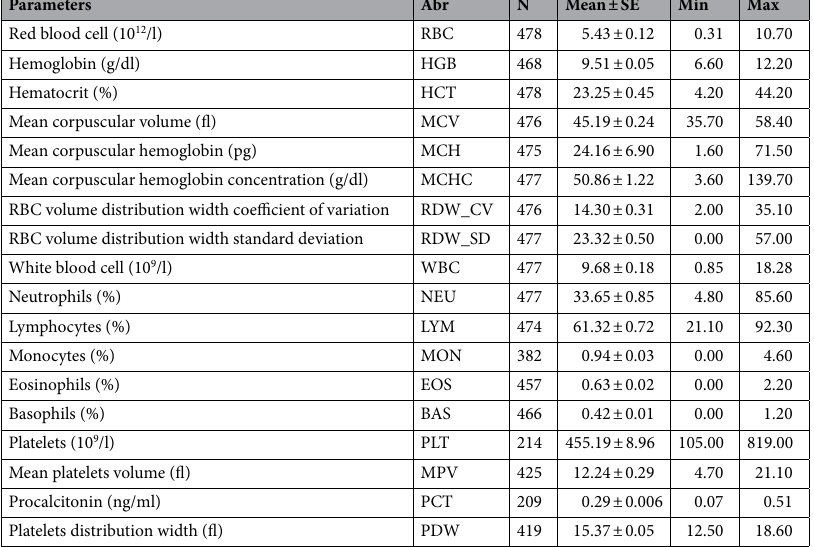
Table 1. Descriptive statistics of blood parameters. N is the number of observations; SE is standard